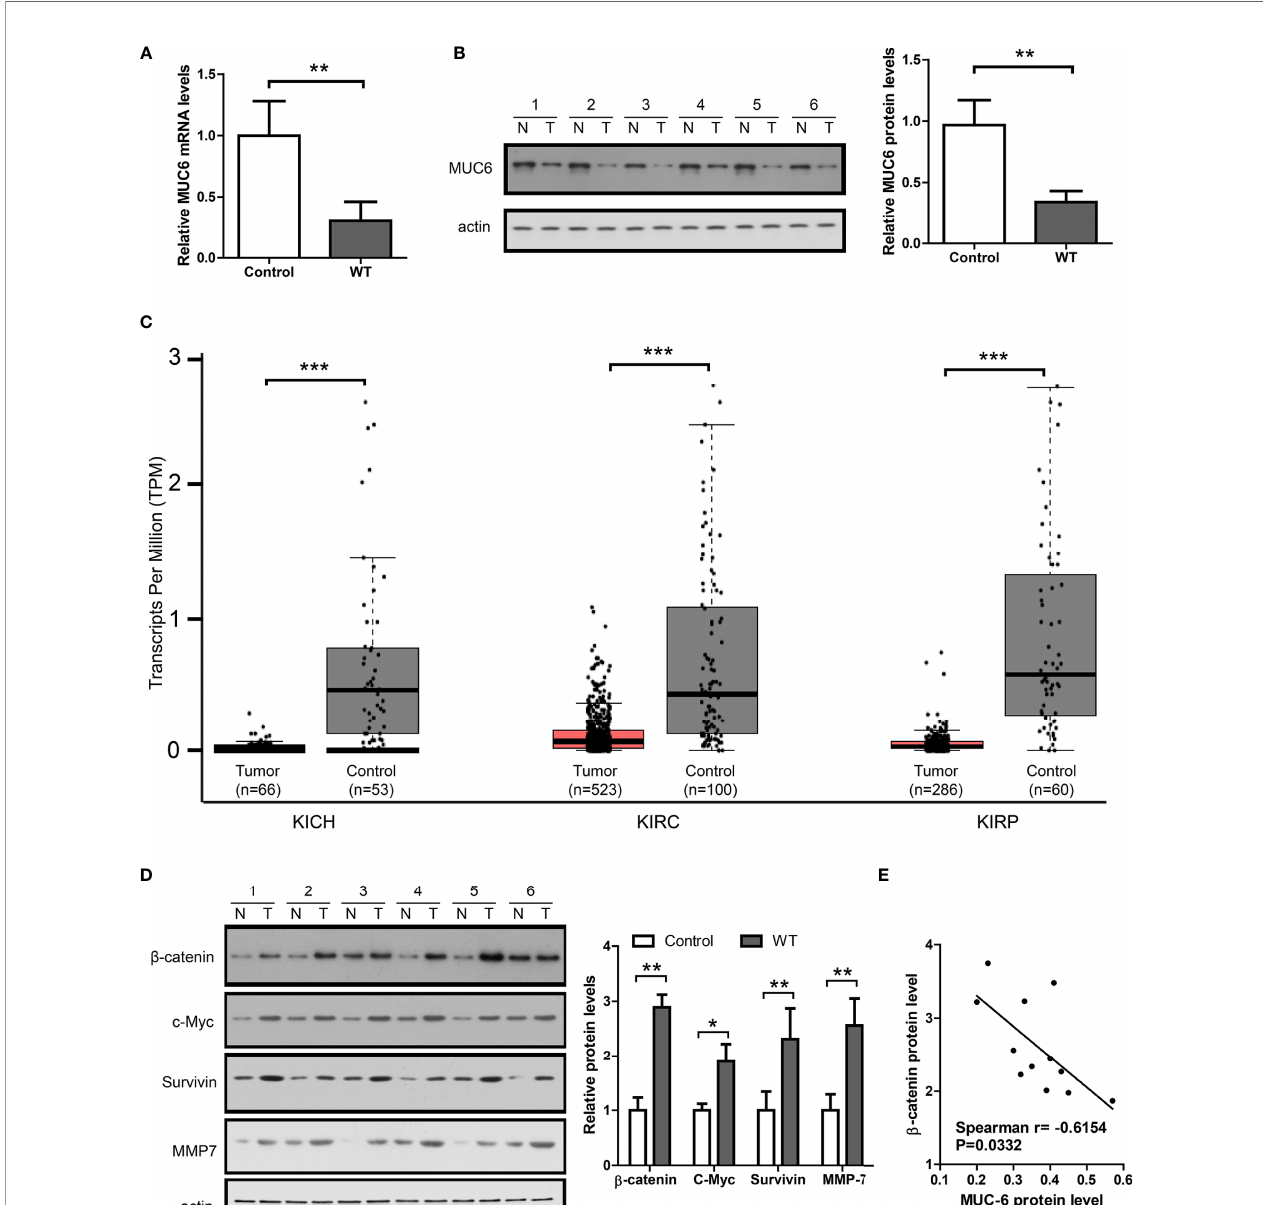
FIGURE 3 | MUC6 expression and its correlation with b -catenin signaling in WT tumor. (A) Real-time PCR results showing MUC6 mRNA levels in 12 pairs of WT tissues. (B) Immunoblots showing MUC6 protein levels in 12 pairs of WT tissues. N indicates normal control tissues and T indicates tumor tissues. (C) whiskers-box plots showing MUC6 expression levels in indicated TCGA datasets. (D) Immunoblots showing protein levels of b -catenin and its downstream target genes including c-Myc, Survivin and MMP7 in 12 pairs of WT tissues. (E) Scatter plot showing the association of MUC6 protein level with b -catenin in WT tumor tissue (Spearman r=-0.6154, P=0.0332). For all, *P<0.05; **P<0.01;